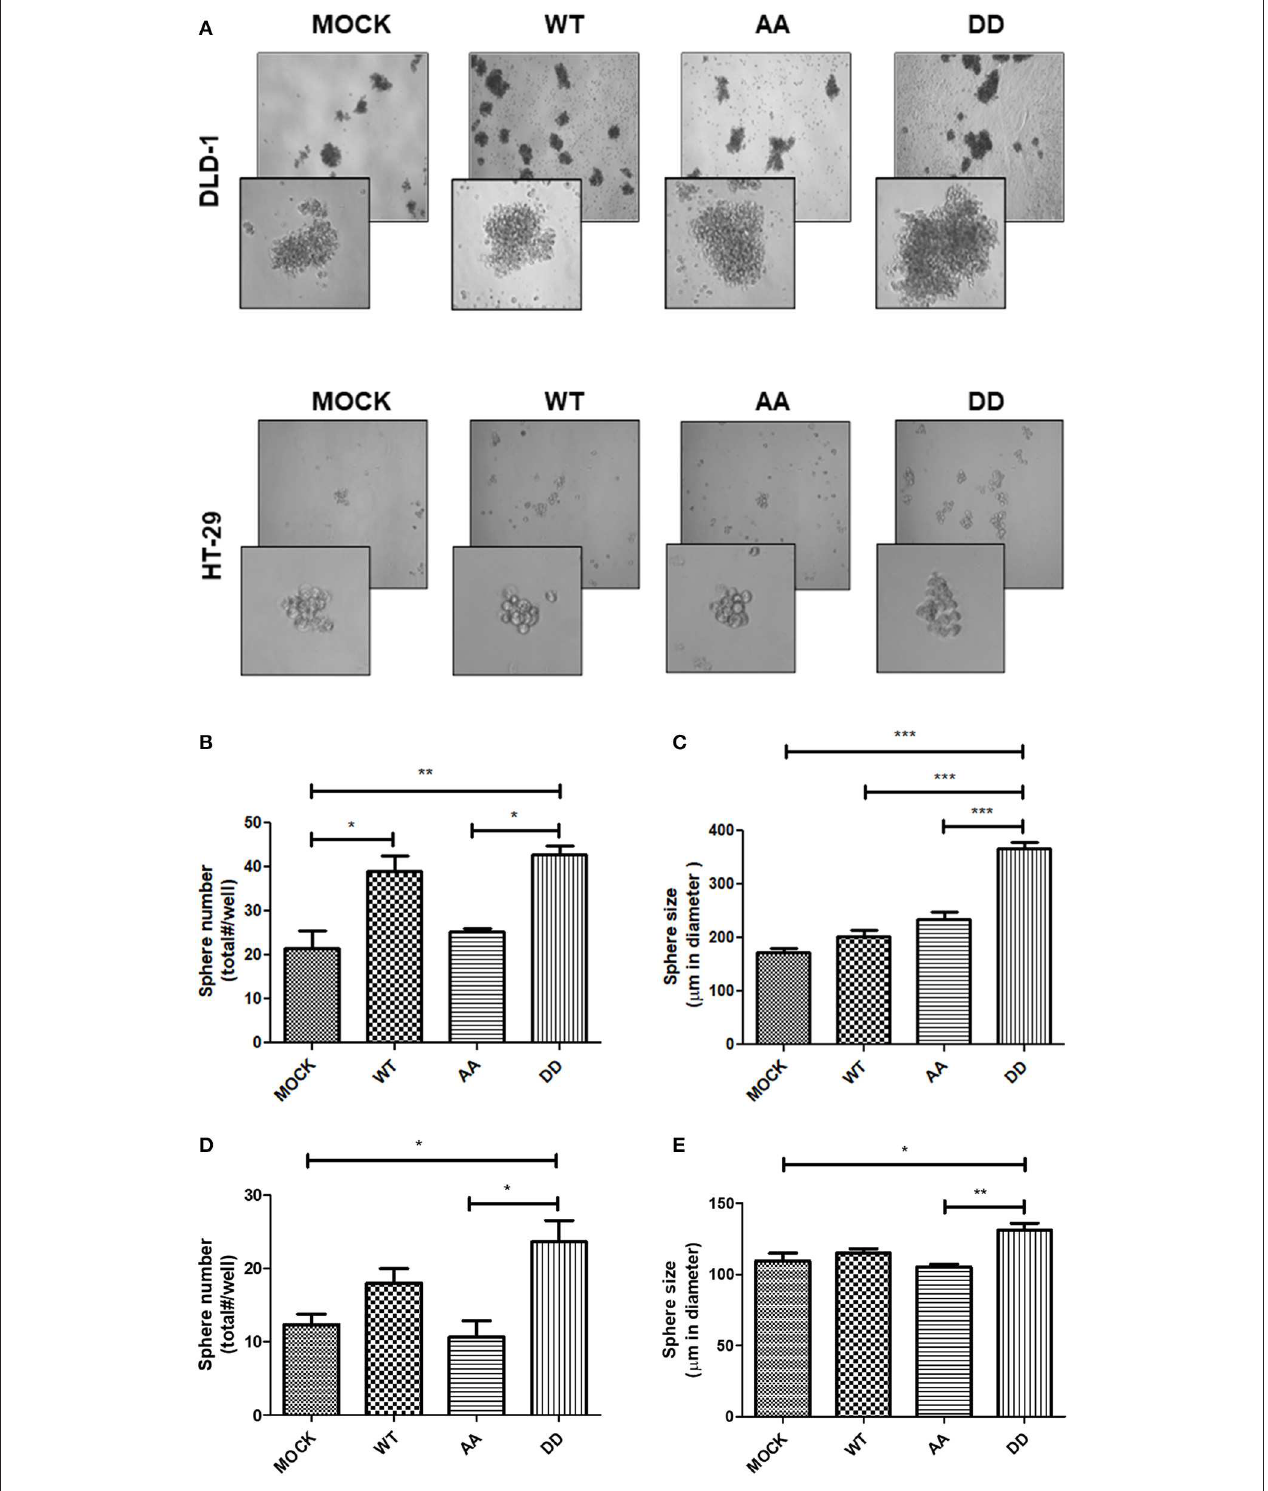
FIGURE 7 | Biphospho-mimetic ECE1c expression enhances aggressiveness of CRC cells. CRC cells stably overexpressing Flag-tagged ECE1c WT , ECE1c AA , or ECE1c DD were grown in MEGM in agarose-coated wells during 7 days. (A) Representative images were taken at 40x and 100x (insert) magnifications by phase-contrast microscopy of DLD-1 (upper) and HT-29 (lower) cells. Spheres over 80 µ m in diameter formed by DLD-1 (B) and HT-29 (C) clones were counted and plotted as total spheres/well. Size of spheres formed by DLD-1 (D) and HT-29 (E) clones was measured using the Micrometrics SE Premium 4 software and plotted as sphere diameter in µ m. Graphs represent mean ± SEM. * p < 0.05, ** p < 0.01, *** p < 0.001.